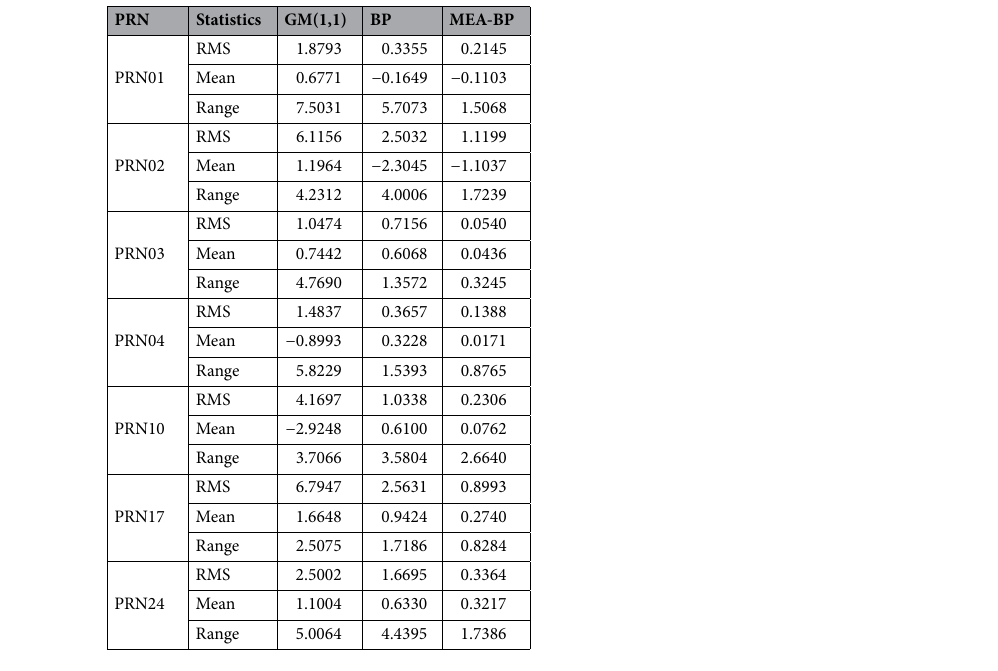
Table 7. Statistics of 6 h prediction results of the seven satellites (unit: